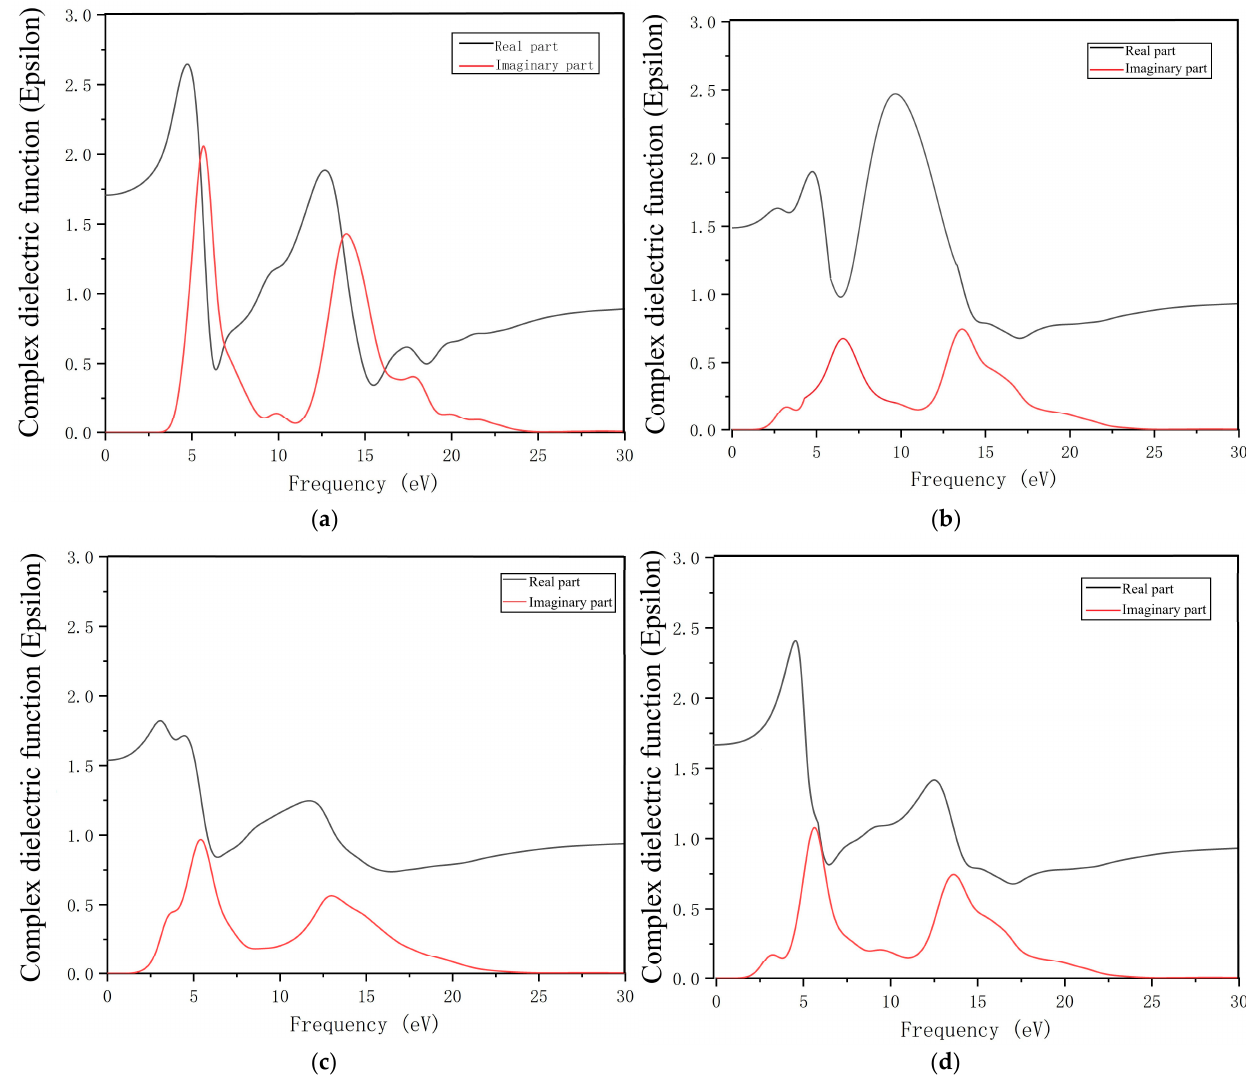
Figure 8. Complex dielectric function of ( a ) intrinsic, ( b ) Cs-doped, ( c ) Br-doped, and ( d ) Cs-Br co- doped boron nitride.